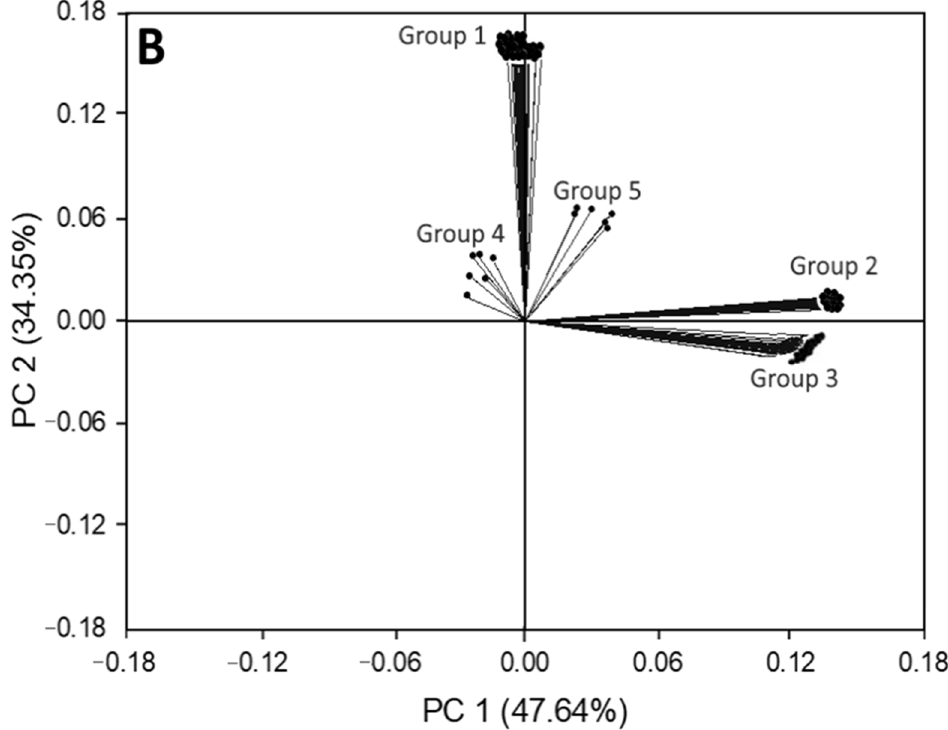
Figure 5. Principle component analysis showing score plot ( A ) and loading plot ( B ) for HAs and PAHs formation as affected by different flavorings and processing time length. Ground pork with different flavoring treatments at various marinating time length was performed by initially preparing the unmarinated juice by mixing 1% of sugar, 10% of soy sauce and 89% of deionized water (standard formula) without or with 0.5% cinnamon powder or 0.5% green tea powder, followed by adding 500 g of raw ground pork and marinating for 2, 4, 8, 12 and 24 h with the temperature controlled at 90 ± 2 ° C. Mean values of triplicate determinations were used for PCA analysis. HAs, heterocyclic amines; tHAs, total HAs content; PAHs, polycyclic aromatic hydrocarbons; tPAHs, total PAHs content; p, unmarinated pork; j, unmarinated juice; p+cp/gp, unmarinated pork flavored with 0.5% cinnamon powder or 0.5 % green tea powder; j+cp/gp, unmarinated juice flavored with 0.5% cinnamon powder or 0.5 % green tea powder; mp2-24 h, marinated pork cooked at 90 ± 2 ° C for different time length (2, 4, 8, 12 and 24 h); mj2-24 h, marinated juice cooked at 90 ± 2 ° C for different time length (2, 4, 8, 12 and 24 h); mp+cp/gp2-24 h, marinated pork plus 0.5% cinnamon powder or 0.5% green tea powder cooked at 90 ± 2 ° C for different time length (2, 4, 8, 12 and 24 h); mj+cp/gp2-24 h, marinated juice plus 0.5% cinnamon powder or 0.5% green tea powder cooked at 90 ± 2 ° C for different time length (2, 4, 8, 12 and 24 h).